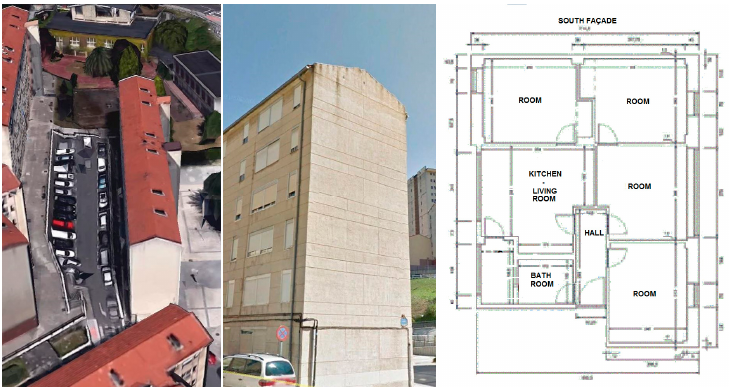
Figure 1. The building in Bilbao 43°15 ′ 30 ″ N, 2°54 ′ 00 ″ W.